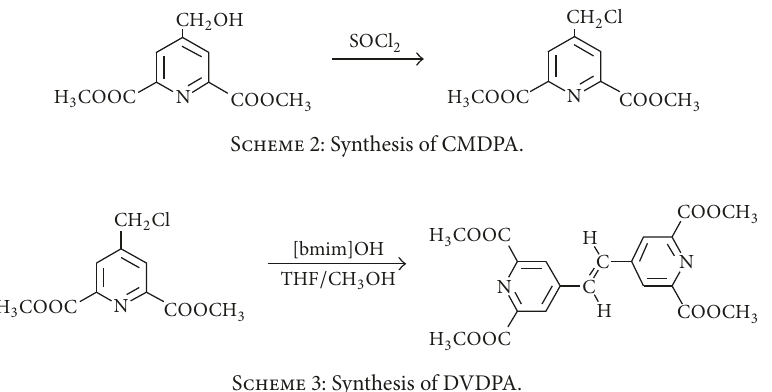
Scheme 3: Synthesis of DVDPA.